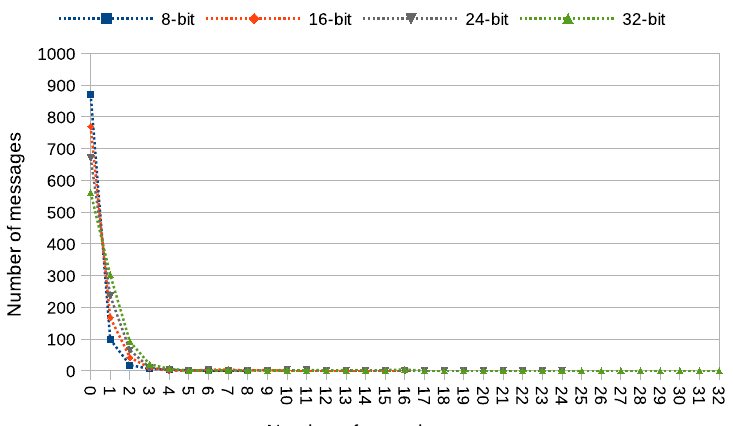
Figure 12. Numbers of messages received with different number of error bits (IEEE 802.11n; Both-informed).